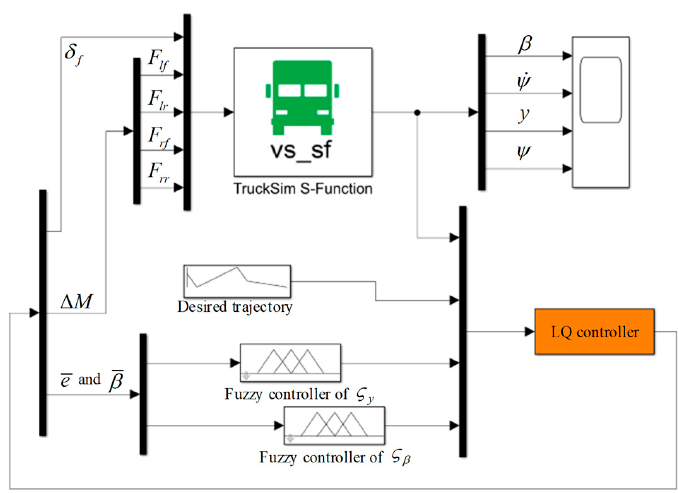
Figure 5. Simulation system based on fuzzy LQ theory.